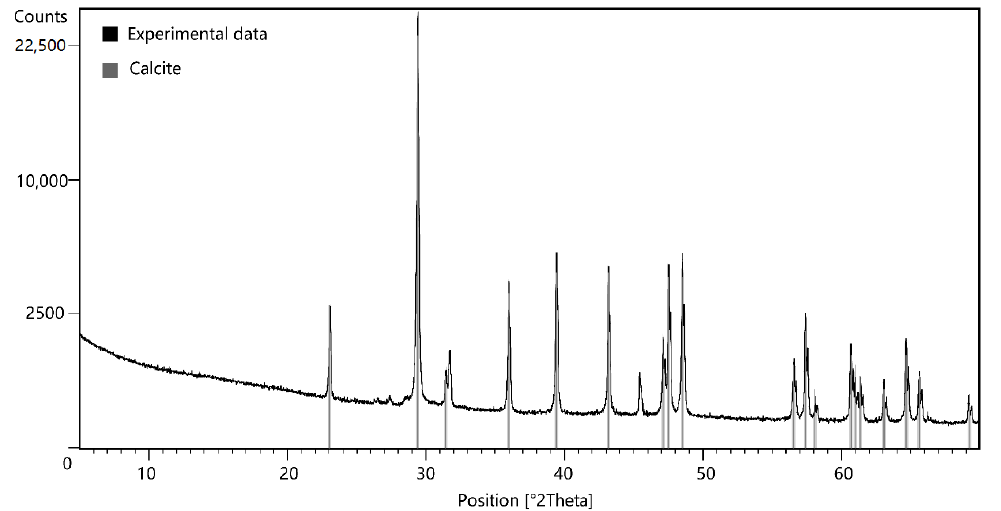
Figure 3. X-ray diffraction pattern of experimental product. Figure 3. X-ray di ff raction pattern of experimental